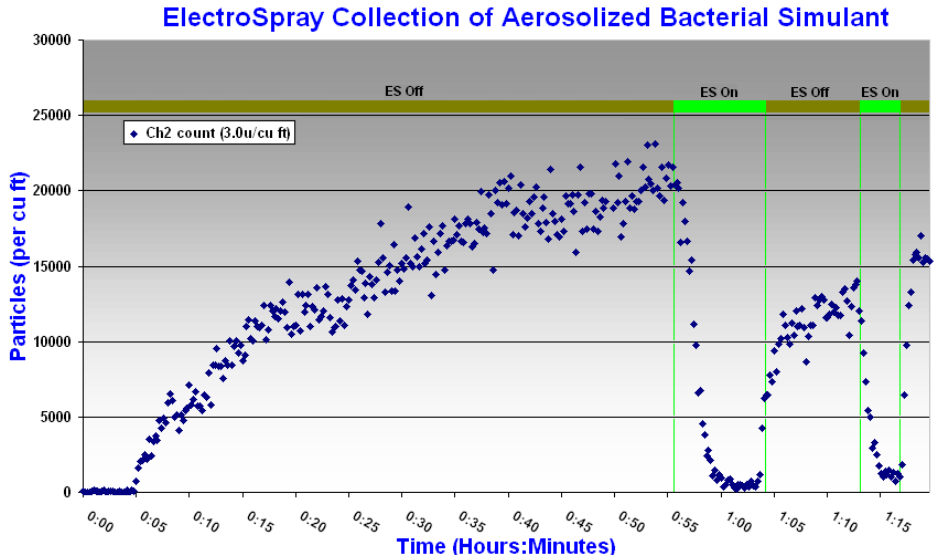
Figure 4. Graph representing aerosol particle concentration using a laser particle counter. An electrospray source when activated captured ambient 3.0 micron bacterial simulant, reducing the overall particle concentration background